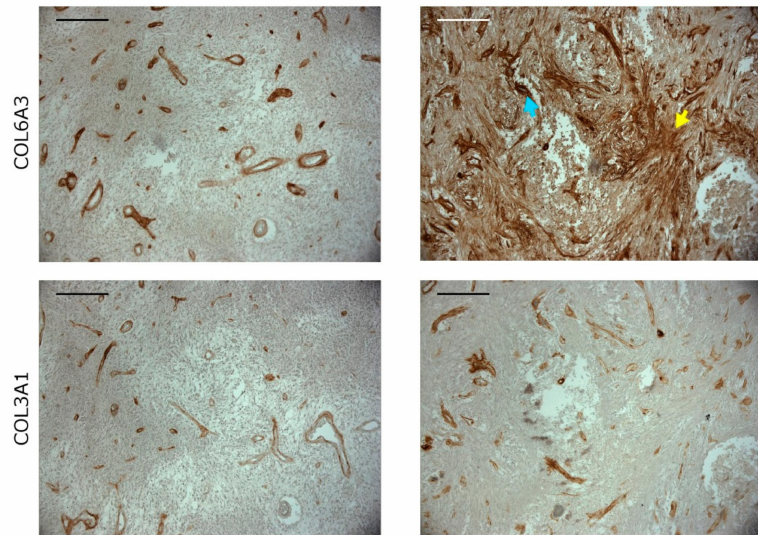
Figure 6. The expression of collagens in the gliomatous and sarcomatous components of gliosarcoma. The left panel shows GFAP positive staining (brownish area) and negative Gomori silver staining (red arrows) in the gliomatous tissue of gliosarcoma. COL6A3 and COL3A1 staining is restricted to the blood vessels of tissue. Positive Gomori (green arrows) and negative GFAP staining (bluish area), (the right panel), of spindle cells marks the sarcomatous component. COL6A3 is expressed mainly around spindle cells (yellow arrow) and blood vessels (blue arrow). COL3A1 is expressed mostly in blood vessels; Bars: 200 µ